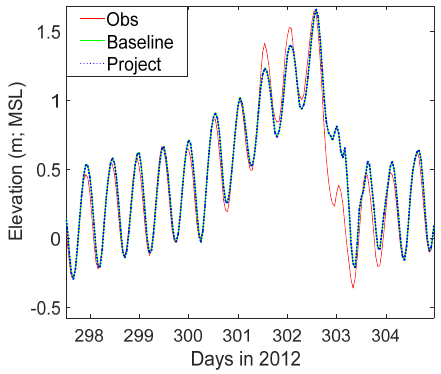
Figure 17. Elevation at Sewells Point (lower James River, see location in Figure 1) during Hurricane Sandy in 2012.